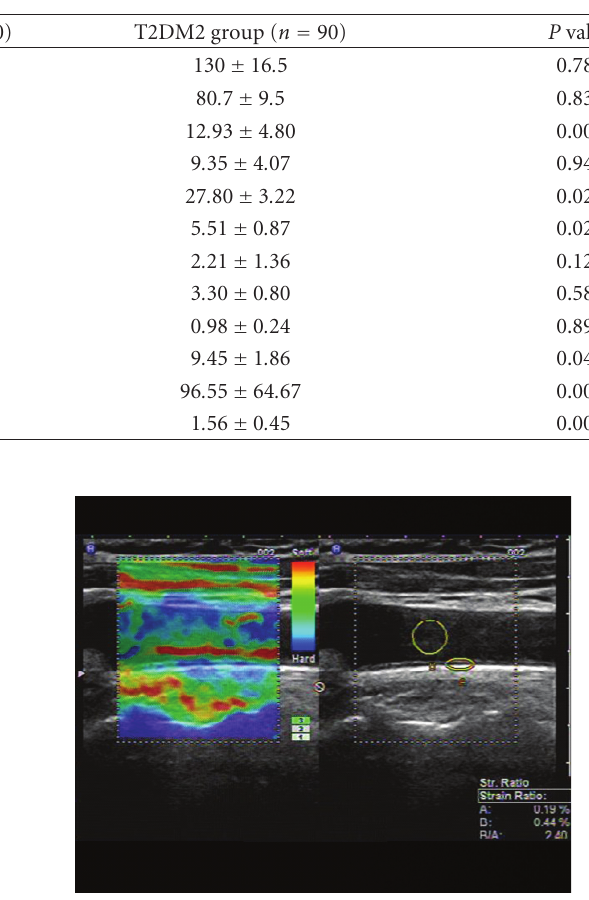
Figure 1: Longitudinal carotid artery image obtained in T2DM1 group on real-time US elastography. The left image shows the elastographic image in di ff erent colors representing di ff erent levels of strain. The right image shows the positions of ROI (A) and ROI (B), and the strain ratio (blood to carotid arterial wall strain ratio) as 1.44, calculated as the blood strain (B, 0.46%) divided by the arterial wall strain (A, 0.32%).